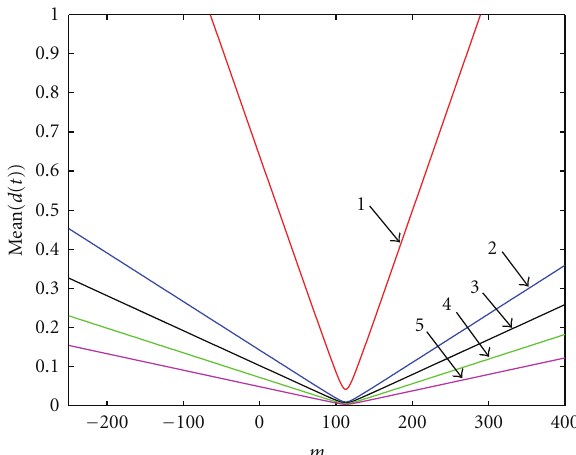
Figure 1: The relationship of mean ( d ( t )) and m under di ff erent coupling parameter values. Curves 1–5 are, respectively, with the parameter of k = − 10 , k = − 50 , k = − 70 , k = − 100 , and k = − 150